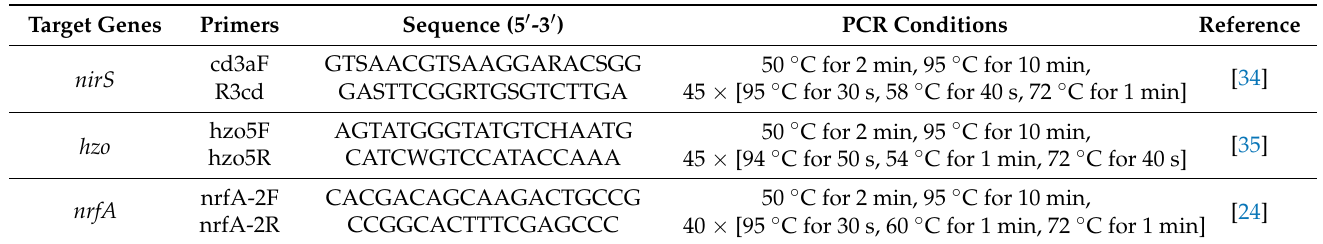
Table 1. Primers and qPCR protocols used in the present